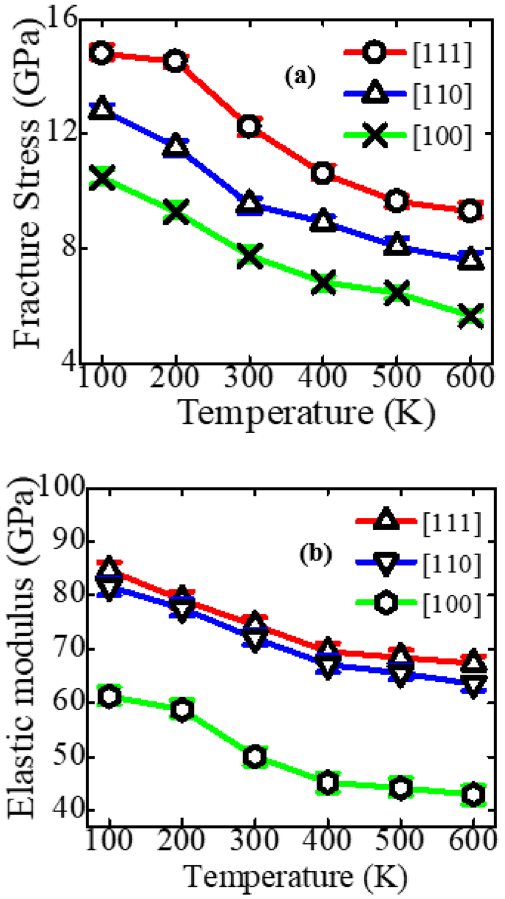
Figure 5. ( a ) Fracture stress and ( b ) Elastic modulus of 15.76 nm 2 zinc-blende ZnSe NWs for different crystal loading directions with different